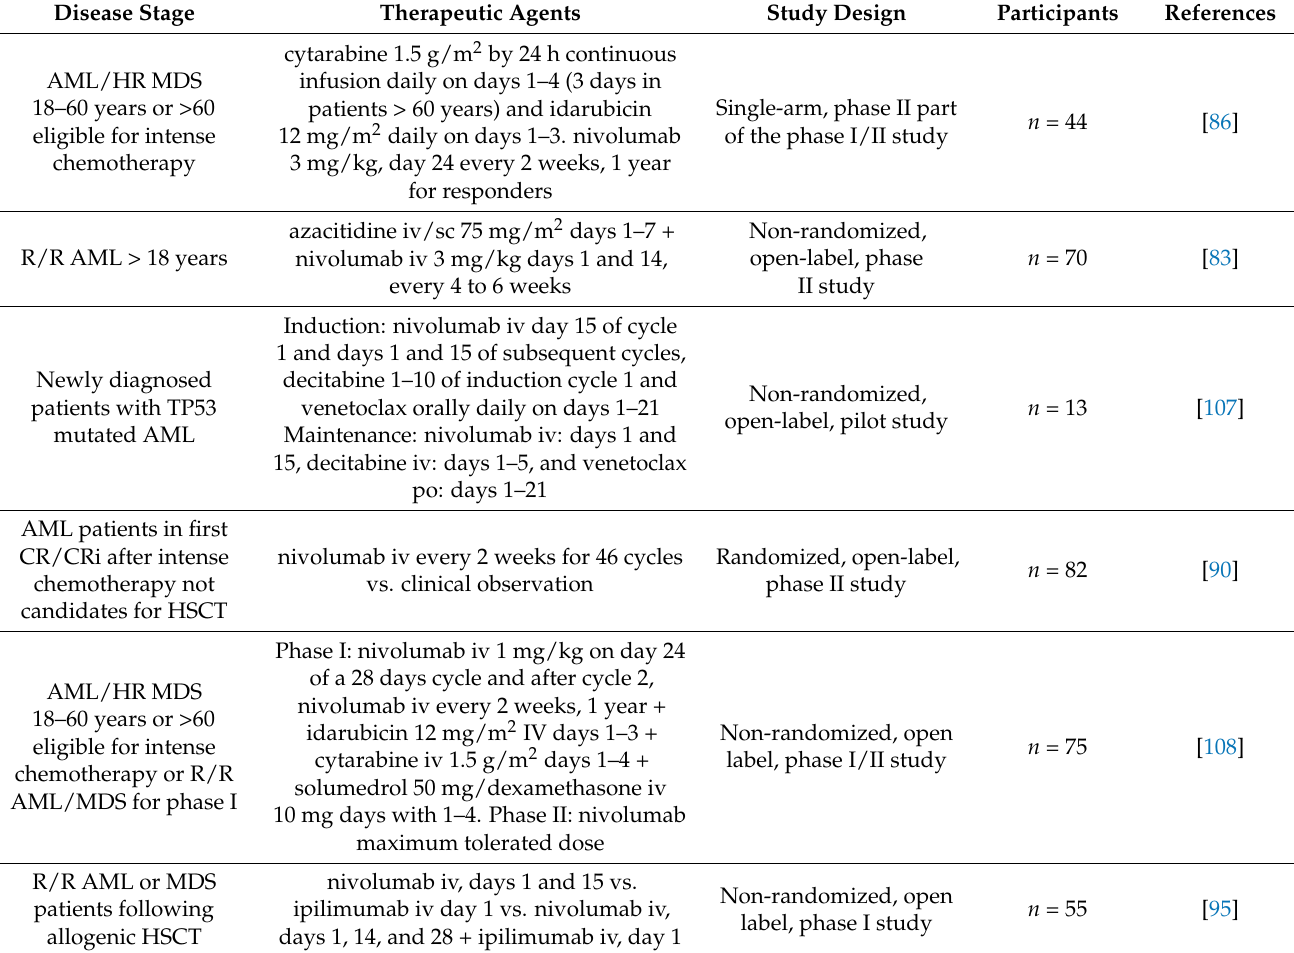
Table 1. Completed and ongoing clinical trials of programmed cell death protein 1 (PD-1), PD-ligand(L)1 inhibitors in AML. Disease Stage Therapeutic Agents Study Design